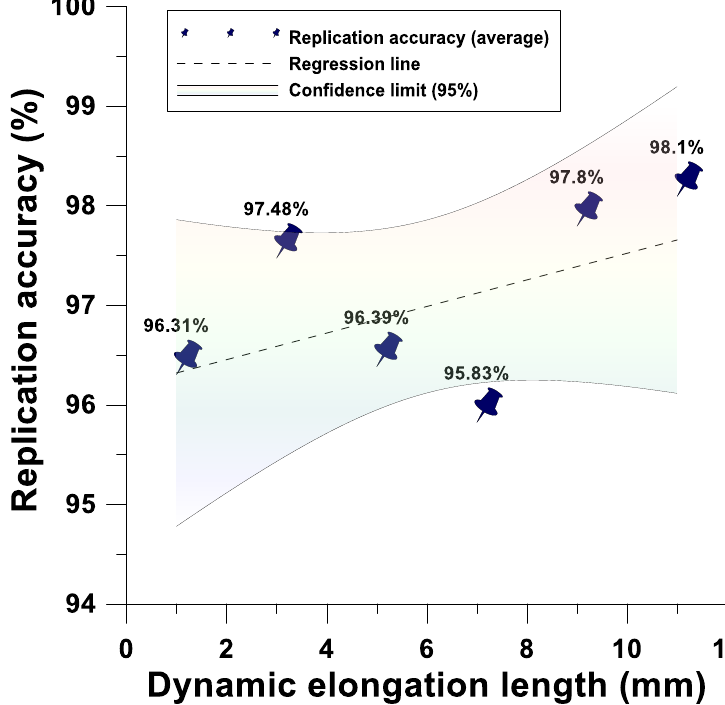
Figure 21. Dynamic tensile and gasbag-assisted imprinting process microstructure height imprint transcription rate.